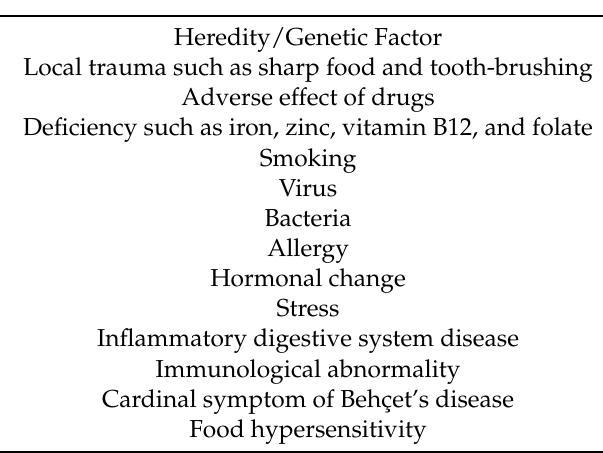
Table 4. Proposed etiology of